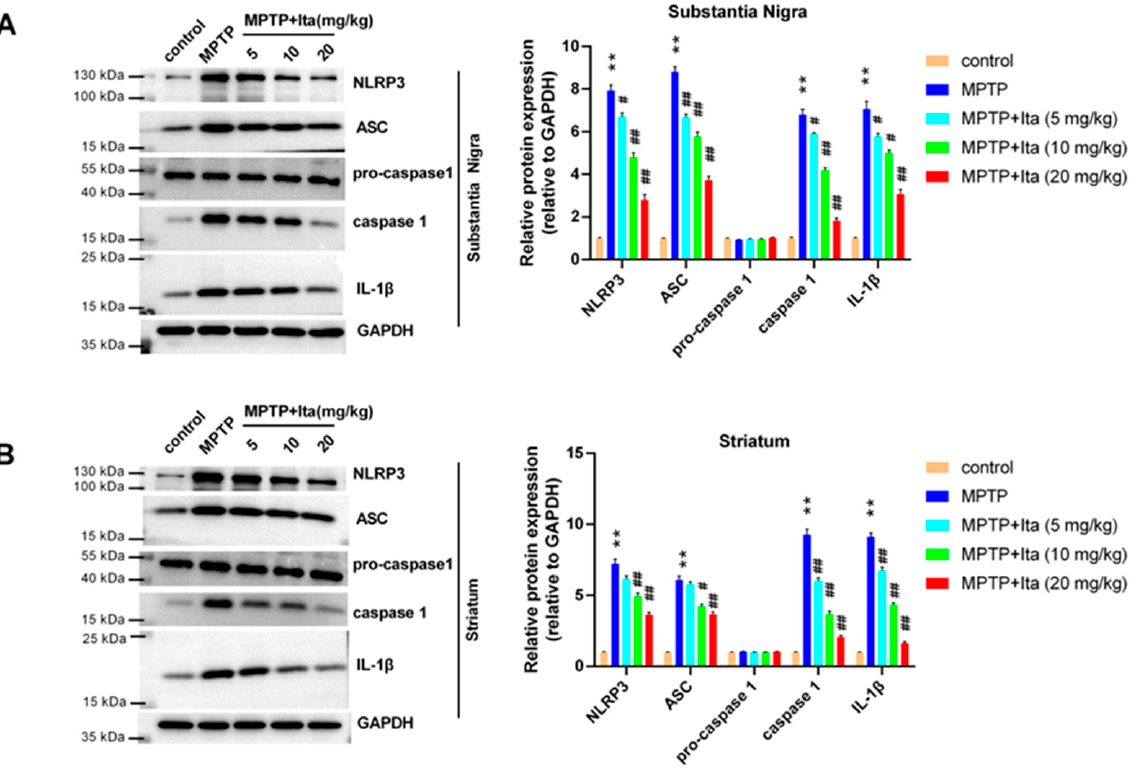
Figure 4. Itaconate inhibited NLRP3 inflammasome in MPTP-caused PD mice model. NLRP3, ASC, pro-caspase 1, caspase 1, and IL-1 β in substantia nigra ( A ) and striatum ( B ) were measured using Western blotting. GAPDH serves as an internal control. n = 5. ** p < 0.01 vs. control group; # p < 0.05, ## p < 0.01 vs. MPTP group. GAPDH, glyceraldehyde-3-phosphate dehydrogenase; IL-1 β , interleu- kin 1 β ; Ita, Itaconate.